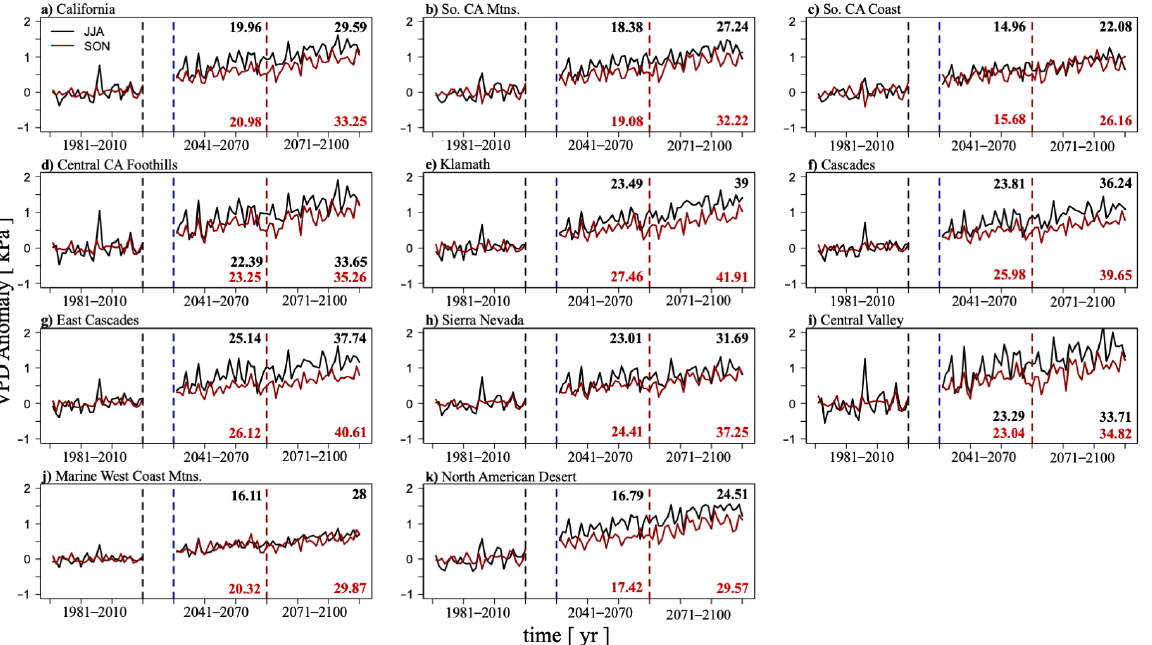
Figure 5. Vapor pressure deficit anomaly relative to the historical period of 1981–2010. Solid black line represents the summer season of June, July, and August, while the solid red line represents the fall season of September, October, November. The dashed vertical black line represents the end of the historical period, while the dashed vertical blue and red lines represent the breaks between the mid- and late-century periods, respectively. The black and red text within the figure is the relative change (%) for the mid- and late-century periods (relative to the historical period) in the JJA and SON seasons, respectively. ( a ) California; ( b ) Southern California Mountains; ( c ) Southern Califor- nia Coast; ( d ) Central California Foothills; ( e ) Klamath; ( f ) Cascades; ( g ) East Cascades; ( h ) Sierra Nevada; ( i ) Central Valley; ( j ) Marine West Coast Mountains; ( k ) North American Desert. Units: kPa.